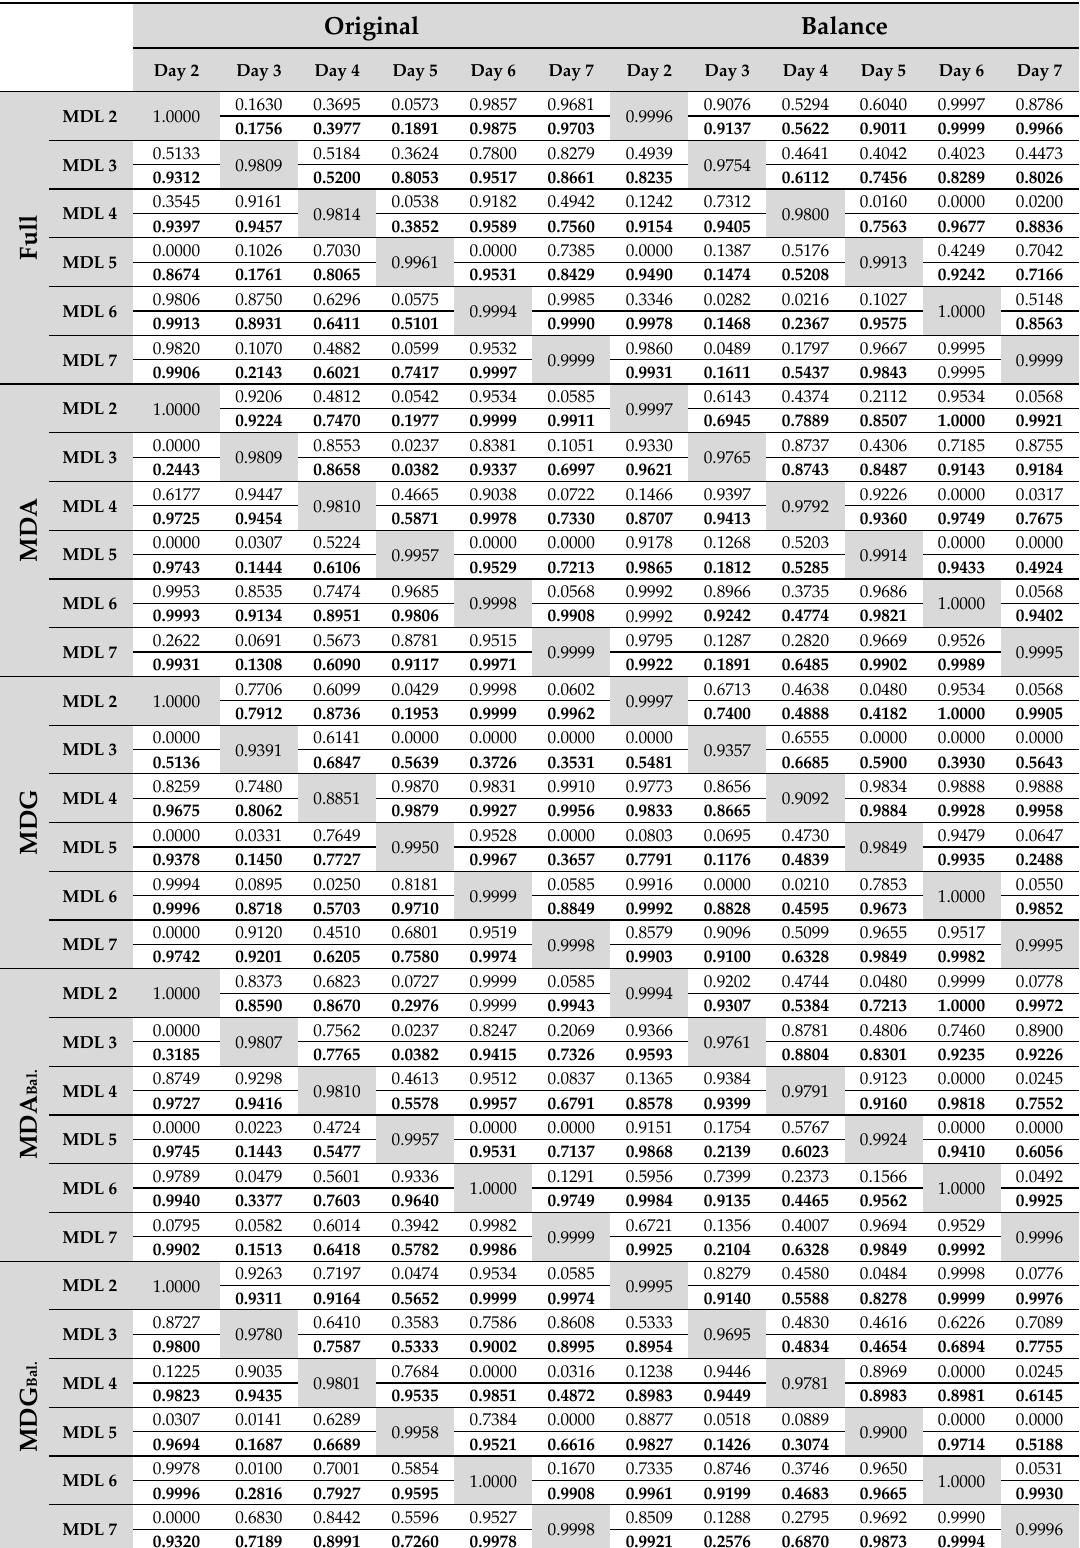
Table A6. The gAcc of models for the fixed optimal (CV) and adapted cut-off (threshold) for the SVM algorithm.